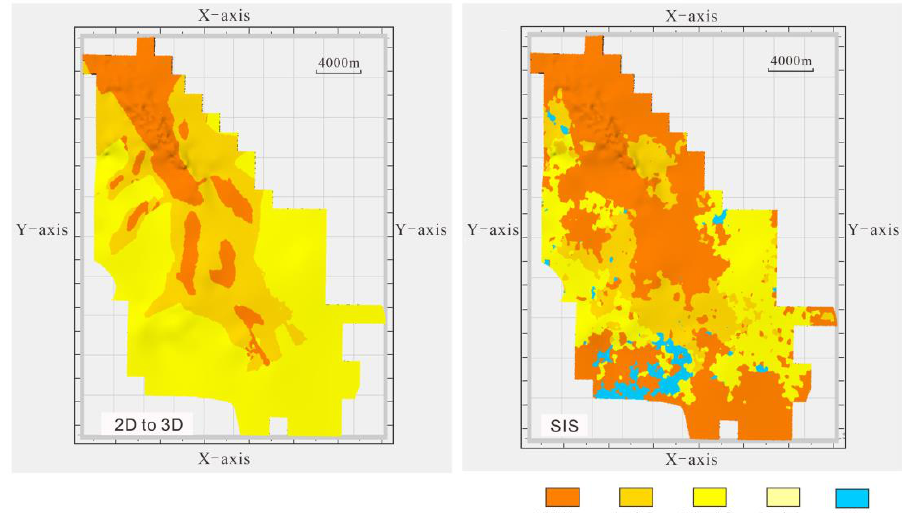
Figure 12. Comparison of modeling results.